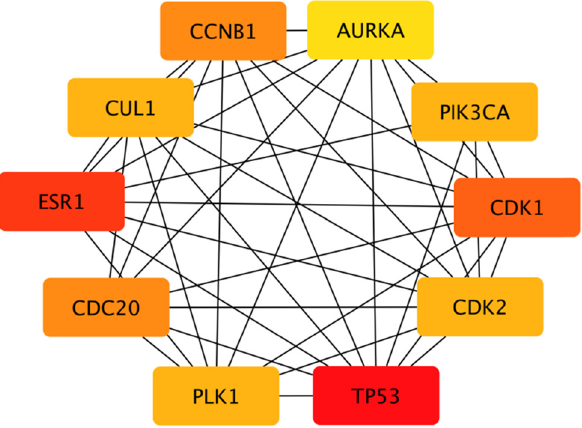
Figure 4: Top hub genes and their interactions of the PPI network. Note: Box colors only represent relative comparison of connection counts of boxes in Figure 3. Deeper red represents more connections.